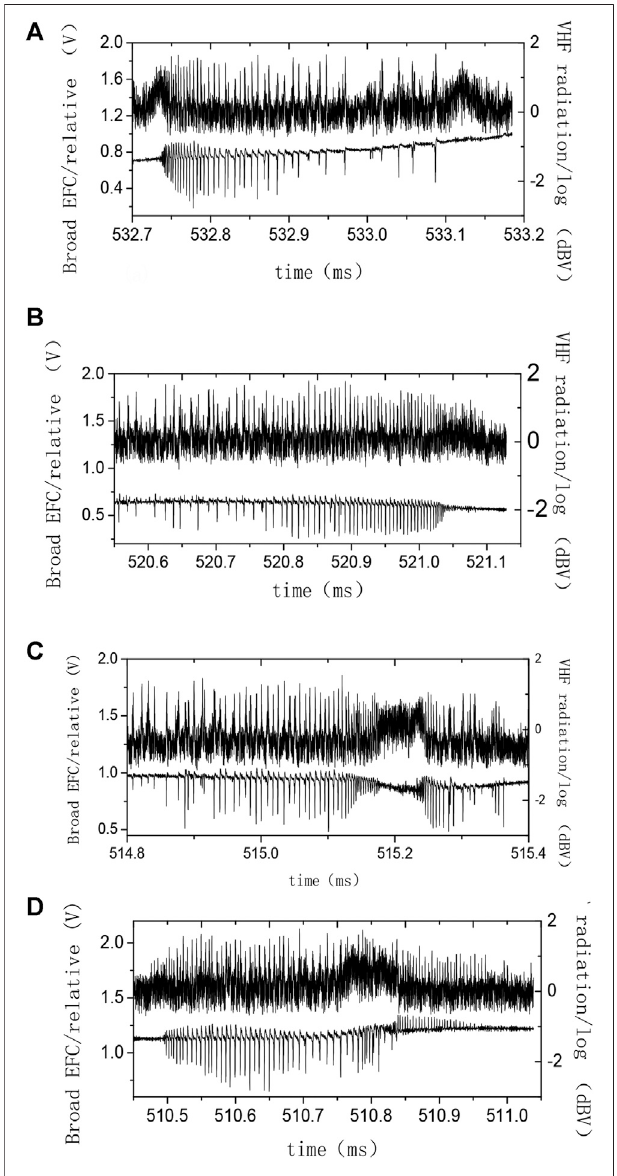
FIGURE 2 | Categories of RPBs. Here (and same below), the upper part is the relative change in VHF radiation and the lower part is the relative change in the VLF/LF radiation in picture. (A) Normal RPBs, (B) back RPBs, (C) symmetric RPBs, and (D) reversal